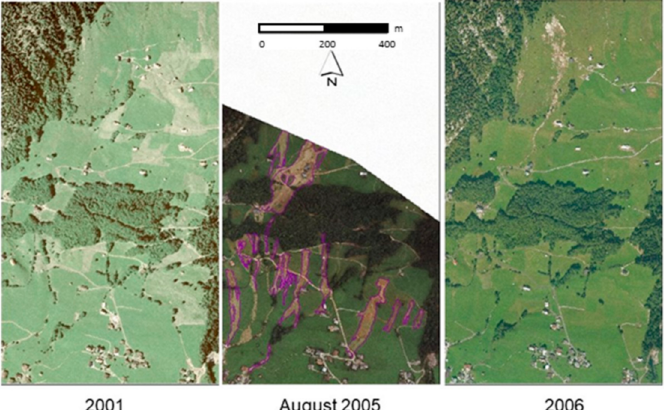
Figure 4. Close-up view of the area around the village Au (landslides highlighted with purple polygons) with the missing gap of the northern area in the aerial-photo of 2005. In the northern part of the aerial photo of 2006 a large landslide scar is visible (aerial-photos©